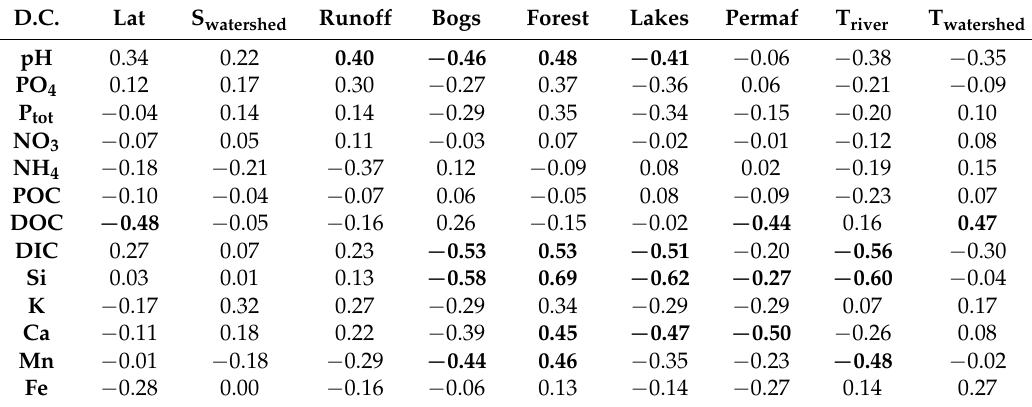
Table 2. Correlation matrix of watershed physico-geographical parameters and dissolved component (D.C.) concentrations in all rivers sampled in June and August. Marked (bold) Pearson correlations R > 0.40 are significant at p < 0.05 (N = 74). S is the area of the watershed; T river is water temperature at the day of sampling; T watershed is mean annual temperature of the watershed. Lat and Permaf represent latitude ( ◦ N) and permafrost coverage of the watershed, %. The bogs, forest, and lakes represent the percent coverage in the watershed.